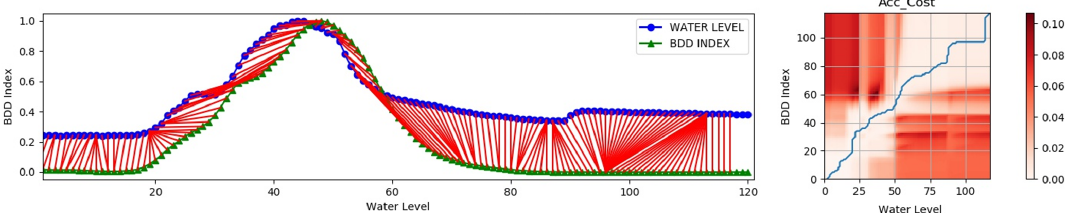
Figure 5. Graphical representation of DDTW correspondences between two first derivatives of time series x(t) and y(t) . In this case, time series are represented by two generic profiles of the hydrometric water level and the BDD index, at the same station point (from Keogh and Pazzani, 2001).